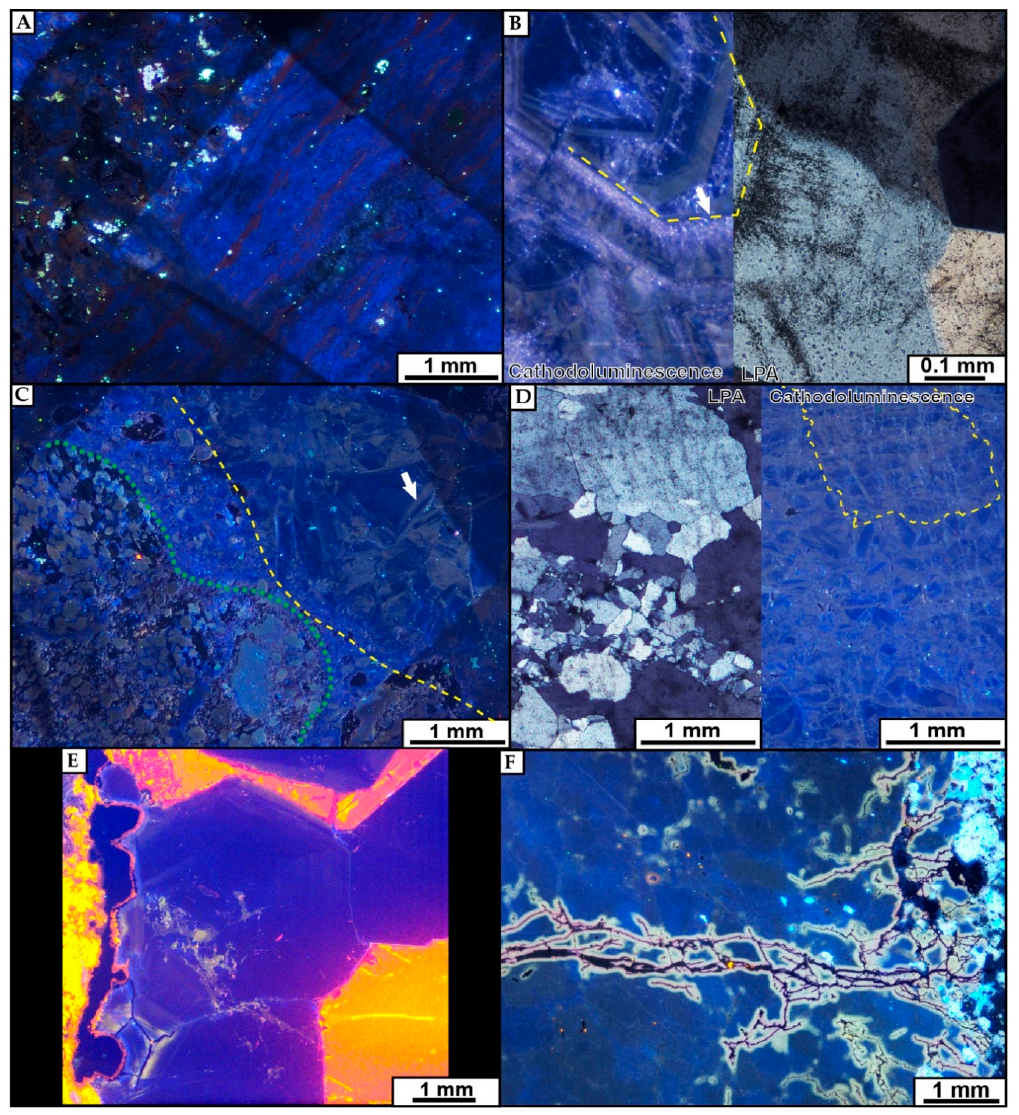
Figure 8. Cathodoluminescence microphotograph (CM): ( A ) Deep blue luminescent microcrystalline quartz and red luminescent hematite in banded vein; ( B ) fracture cemented with euhedral quartz (blue-brown luminescence in concentric zoning, yellow dotted line) and arrays of purplish FIs (white arrow); ( C ) quartz breccia (green) cemented by subhedral, sub-millimetric blue-purple quartz, crosscut by dark blue luminescent subhedral millimetric quartz vein (yellow), the white arrow highlight brown-luminescent overgrowth; ( D ) OM and CM of the same zone: Subhedral and microcrystalline quartz (blue luminescence) displaying microbrecciation/recrystallization (brown luminescence). Yellow dashed line outlines a quartz crystal; ( E ) dark blue luminescent euhedral syntaxial quartz. The boundary of the fracture on the left is lined with U-oxides (black and calcite (orange); and ( F ) quartz vein orthogonally crosscut by a microfracture and cemented with pitchblende. The boundaries of the microfractures display a “buffer area” where the luminescence of the quartz is modified, from pink to yellow.